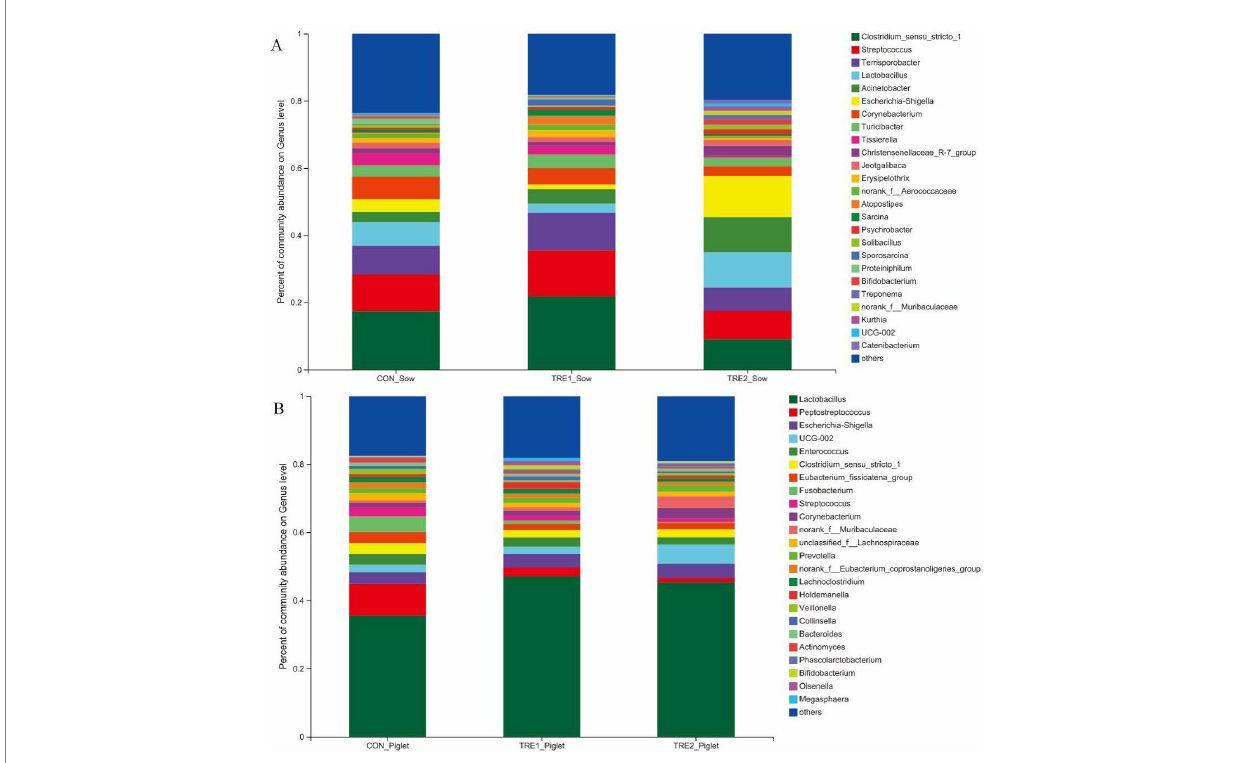
FIGURE 4 Fecal microbiota species of sows and piglets at genus level among different groups. (A) Fecal microbiota for sows among different groups. Sows are regarded as the experimental units, N = 5 for each group. (B) Fecal microbiota for piglets among different groups. Piglets are regarded as the experimental units, N = 5 for each